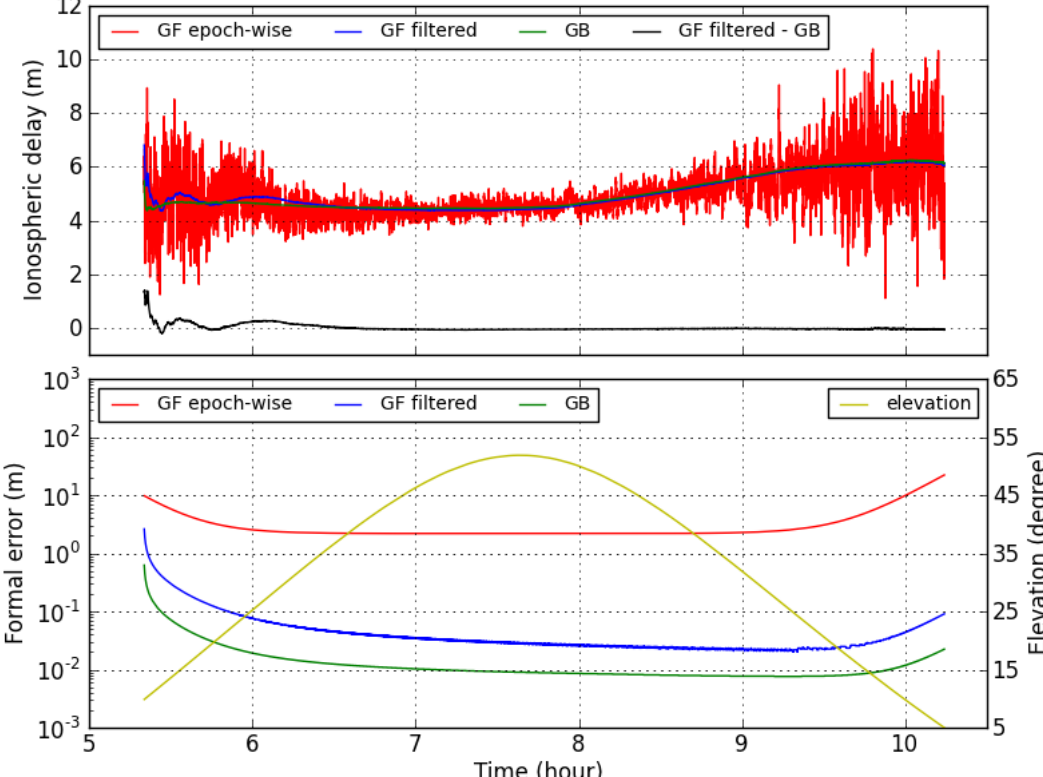
Figure 2. Geometry-free (GF) epoch-wise (red), GF filtered (blue), and geometry-based (GB) (green) ionospheric delays ( top ) and their corresponding formal errors ( bottom ) for PRN 09 computed from the single receiver (GODZ) observations and the ESA final orbit and clock (OC) product. The differences between the GF filtered and GB ionospheric delay are shown in black in the top panel. The elevation of the PRN 09 is displayed in yellow in the bottom panel. GPS time is used for this figure and for all of the following figures as well.